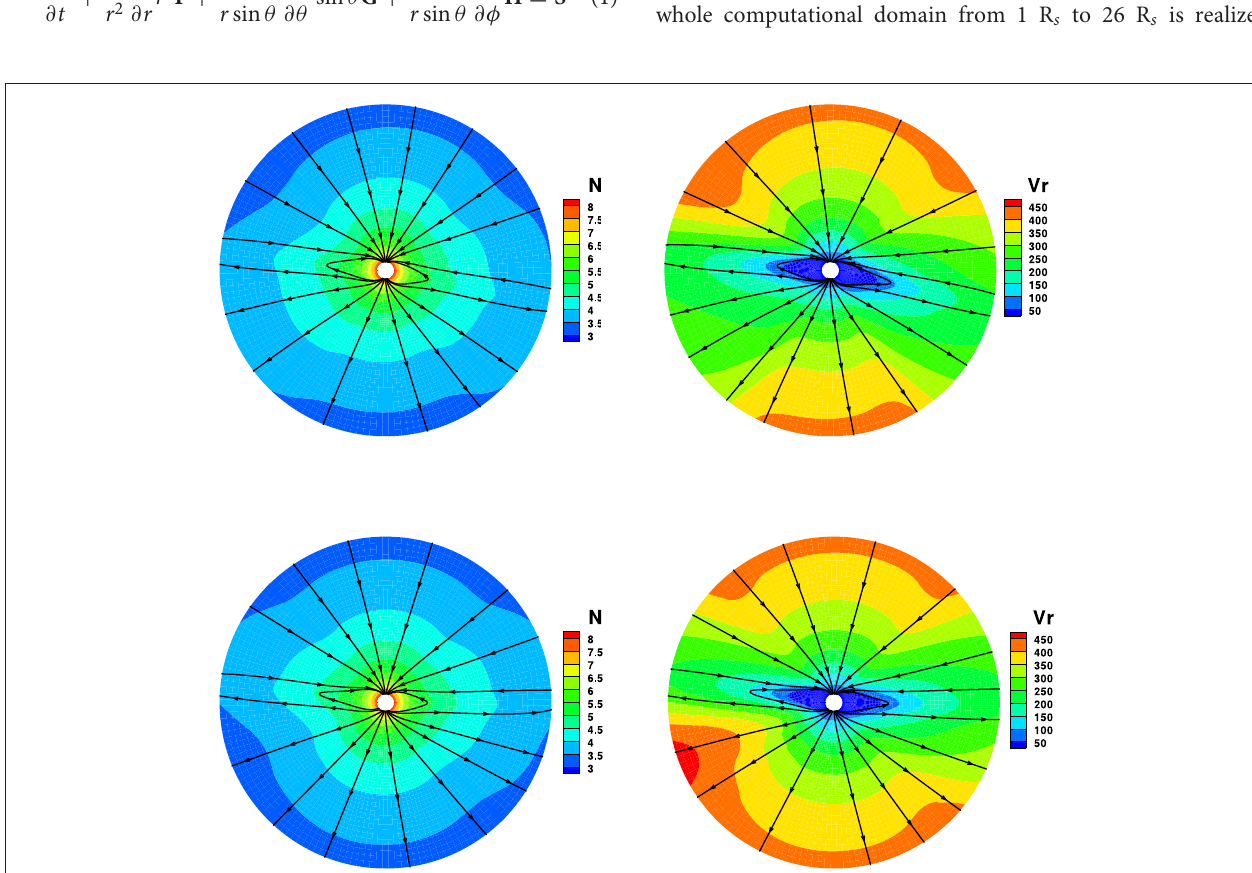
FIGURE 4 | The model results with projection divergence cleaning method, the magnetic field lines, radial speed v r (km/s), and number density N ( log 10 / cm 3 ) on the meridional plane of φ = 180 ◦ − 0 ◦ (top) and φ = 270 ◦ − 90 ◦ (bottom) from 1 to 20 R s .